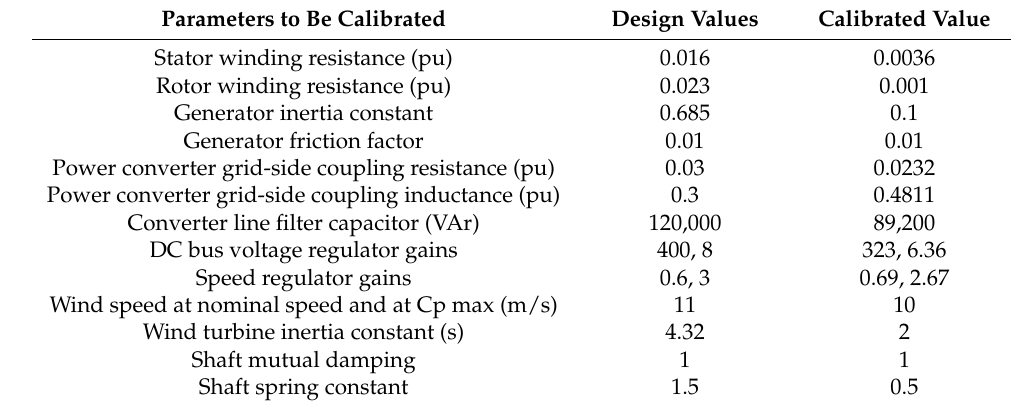
Table 4. Design and calibrated values of parameters involved in the optimization process.